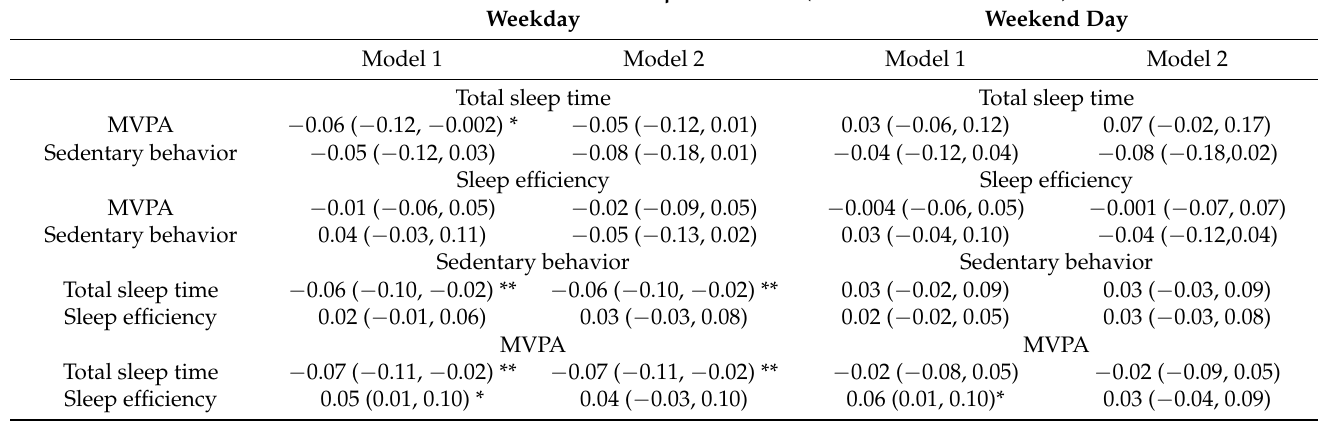
Model 1: control for MVPA or sedentary behavior; Model 2: control for Model 1 and age, sex, fitness, and cognitive performance. MVPA: moderate-to-vigorous physical activity; TST, total sleep time. p -value * < 0 0.05, ** < 0 0.01. Variables were z-score-transformed prior to model